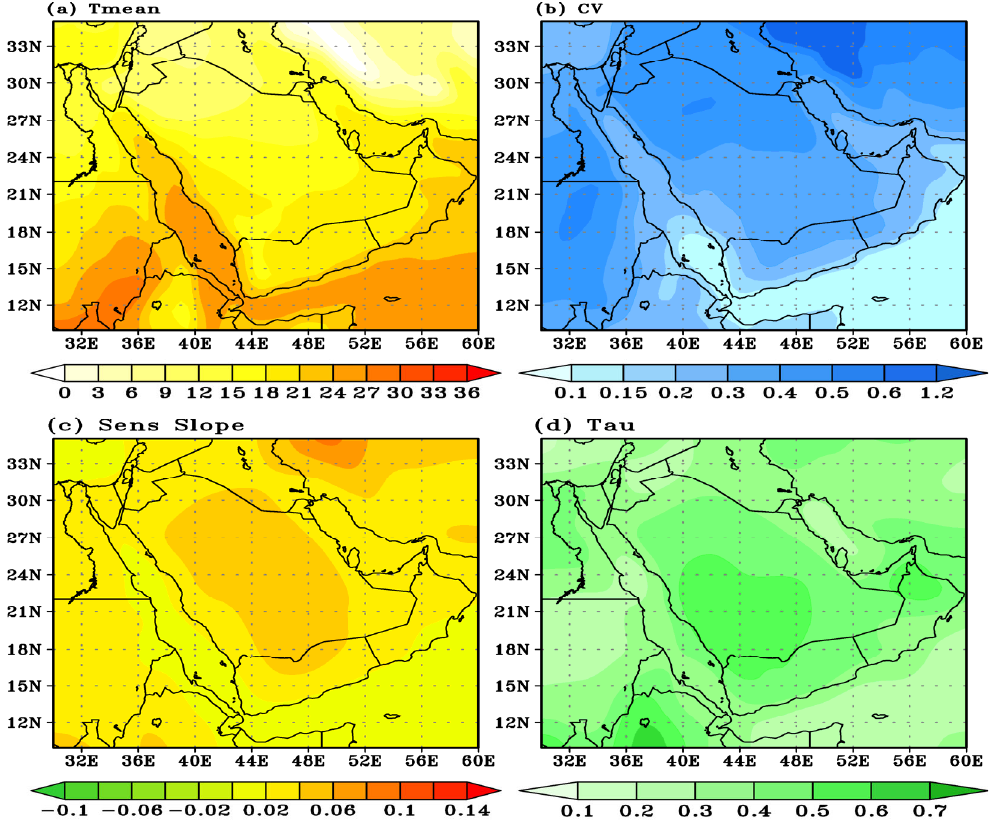
Figure 7. The horizontal distribution of ( a ) Tmean, ( b ) coefficient of variation, ( c ) trend magnitude (Sen’s slope °C/year), and ( d ) Kendall’s Tau of Winter Air Temperatures during (1959–2022) over Saudi Arabia.